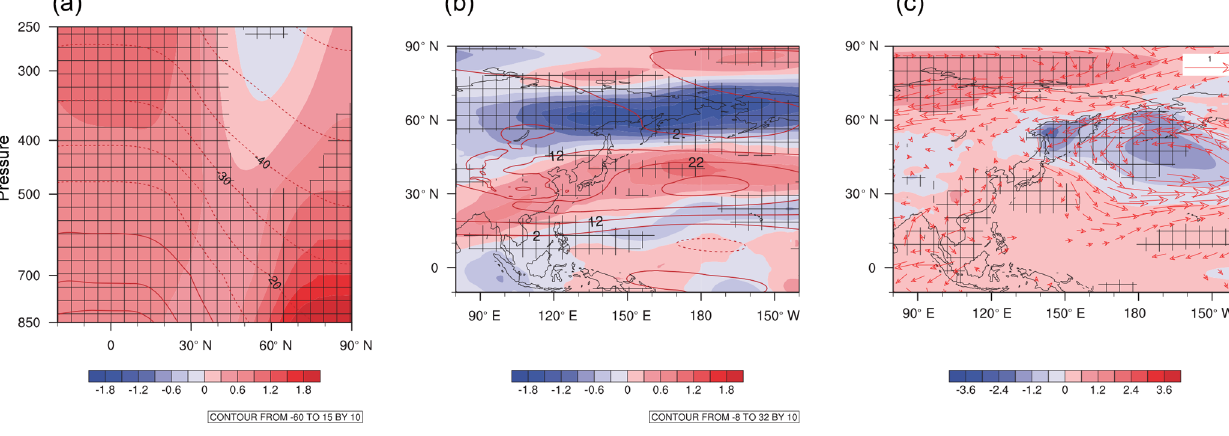
Figure 4. Composite differences of winter-mean (a) air temperature (shading, ◦ ) over 90–150 ◦ E, (b) 250hPa zonal wind (shading, ms − 1 ), and (c) sea level pressure (shading, hPa) and 850hPa wind (vector, ms − 1 ) between the All-Hist runs and Nat-Hist runs, during 1960–2012. Red contours denote the climatology of the All-Hist runs. The plus signs denote where the composite differences are significant at the 95% confidence level based on a two-sided Student’s t